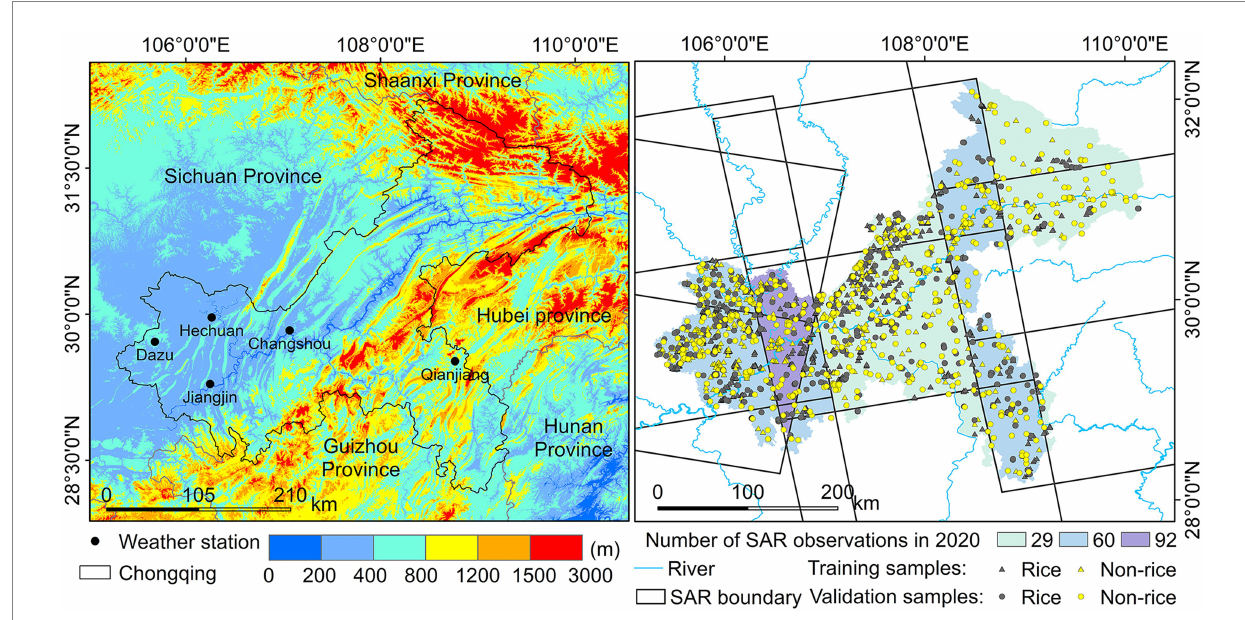
FIGURE 1 Topography of the study area, spatial range of SAR observations and spatial distribution of sample